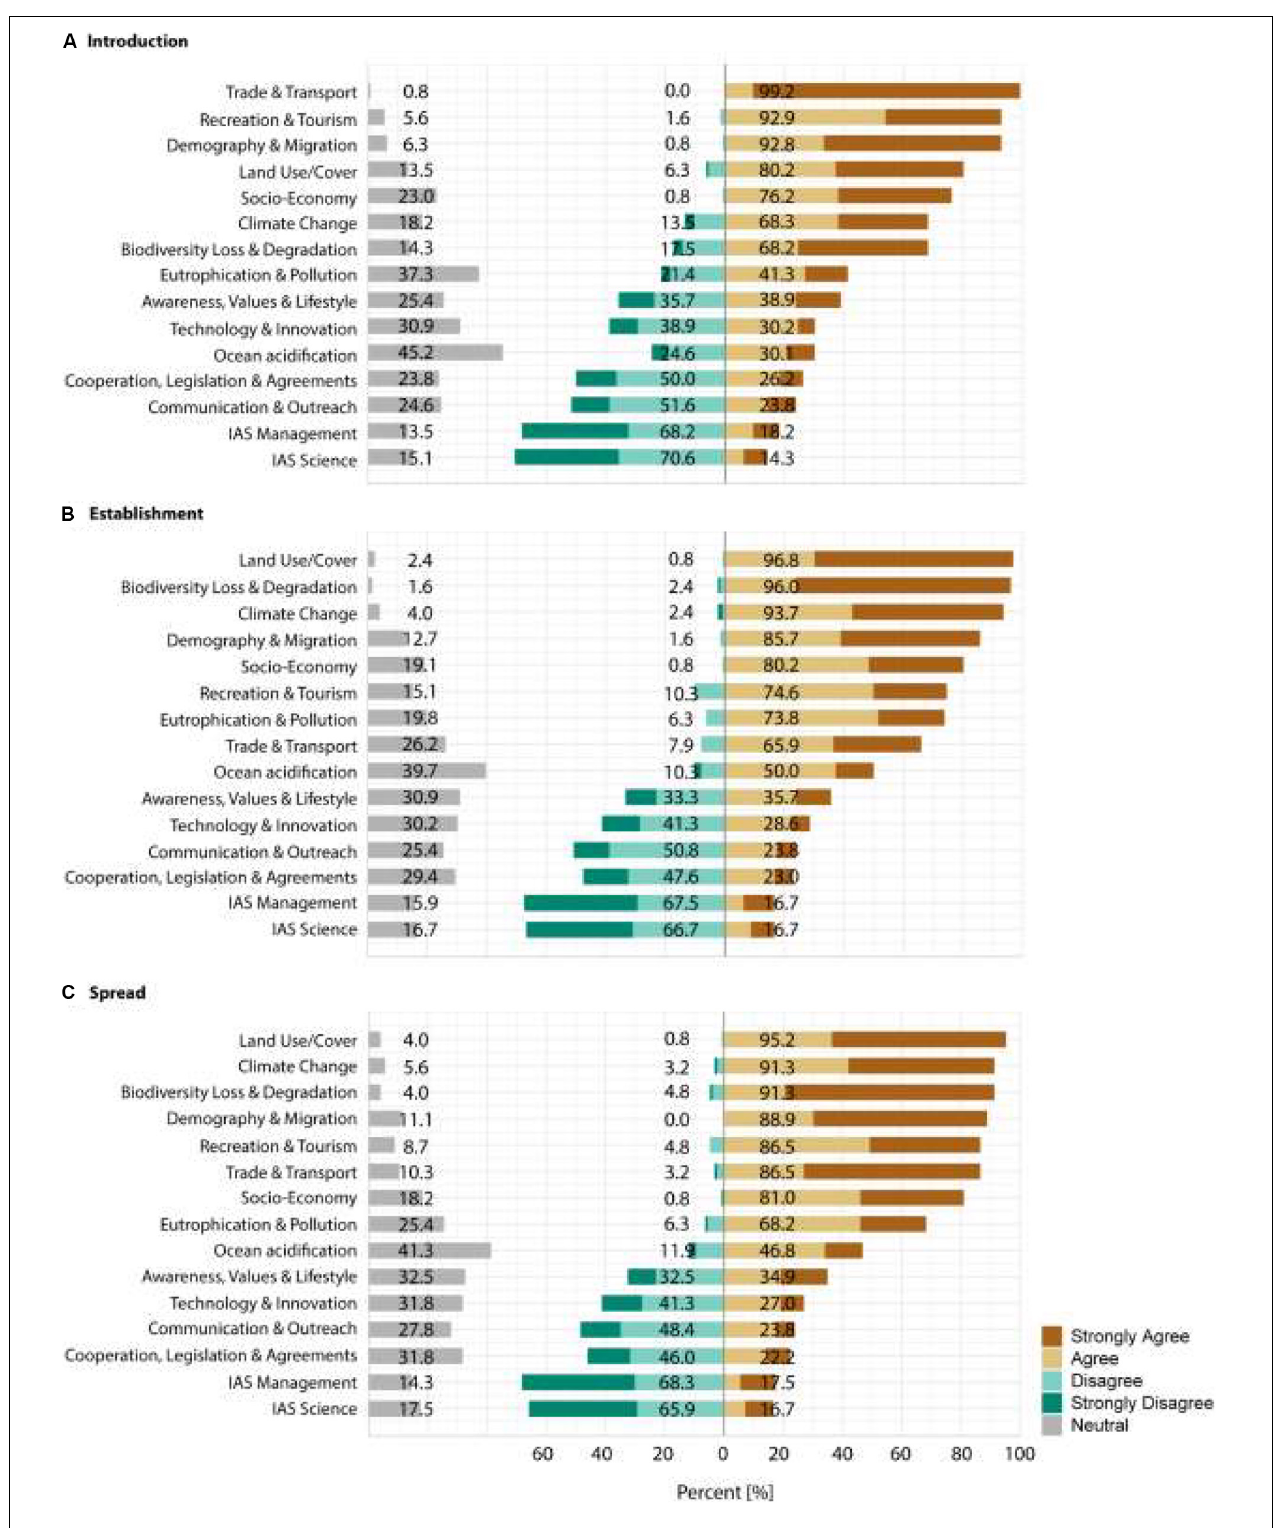
FIGURE 2 | Summary of the answers provided by the 126 respondents for the first section of the survey. Respondents were asked which of the drivers will significantly increase alien species (A) introductions, (B) establishment and (C) spread to/on islands in the 21st century. Answers were provided on a 5-point Likert scale with the categories: strongly disagree, disagree, neutral, agree and strongly agree. Shown is the percentage of agreement with each of the categories. Values are given for the percent of answers in the neutral category and for the disagreement and agreement categories grouping the respective two answer possibilities.